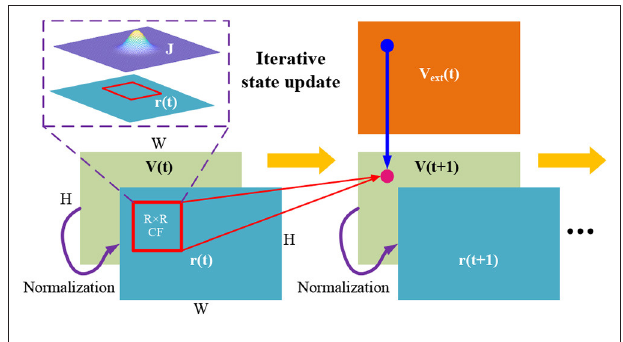
FIGURE 4 | State update described by “ { r ( x , t ) & V ext ( x , t ) } ⇒ V ( x , t + 1) ⇒ r ( x , t + 1) ⇒ ...” according to the discretized difference Equation